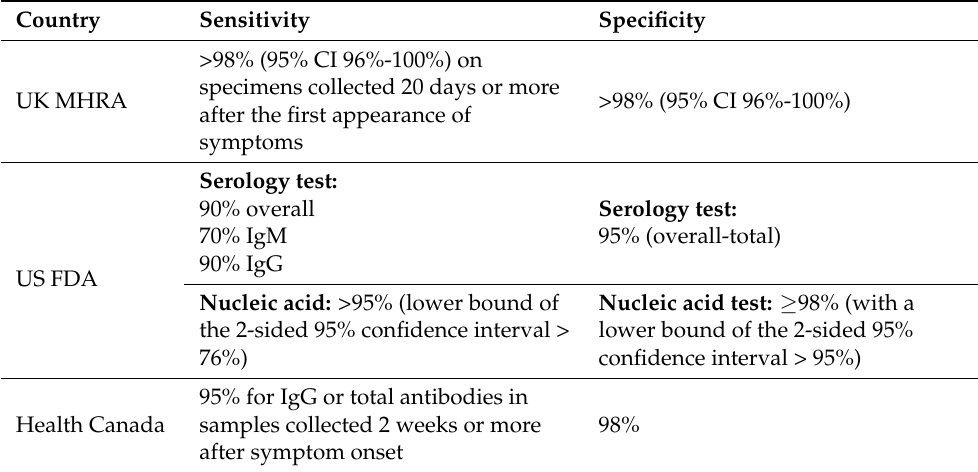
Required sensitivity and specificity for serological